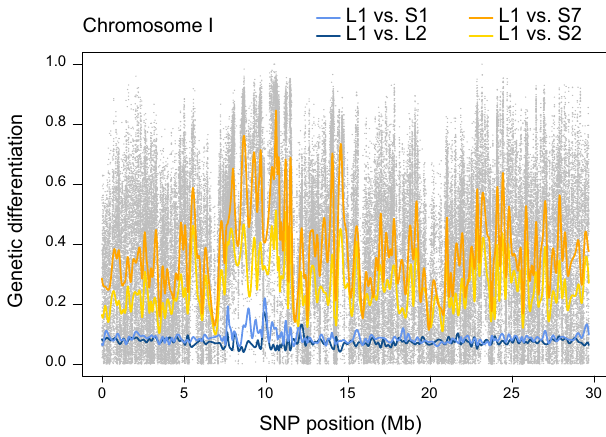
Fig. 3 Pairwise genetic differentiation between clinal sites along a representative chromosome. Genetic differentiation is expressed as absolute allele frequency differentiation (AFD) for four site comparisons, each involving the lake site L1. The colored lines represent differentiation smoothed across SNPs by non-parametric regression. For the comparison between the endpoint samples (L1-S7), differentiation is additionally shown for all SNPs individually (gray dots). Note that the differentiation pro fi le from the L1-S1 comparison resembles the within-lake (L1-L2) comparison, except for a few genome regions particularly strongly differentiated in the L1-S1 comparison. The latter also prove exceptionally strongly differentiated between the lake and the more distant stream